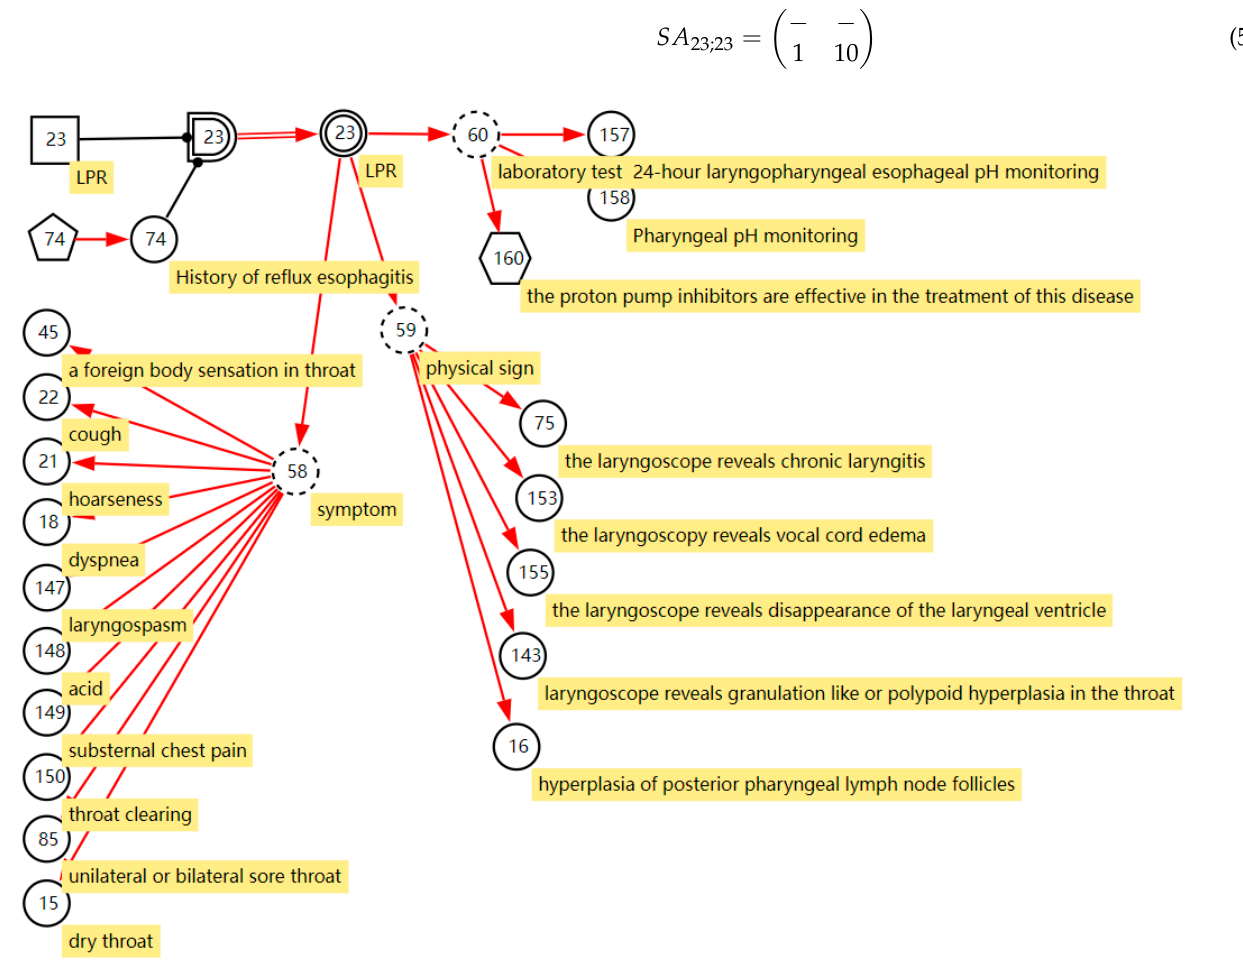
Figure 3. The DUCG of laryngopharyngeal reflux. 23 ) stands for the incidence of the disease when X 74,1 is true, Pr{ BX 23,1 }= Pr{ SA 23,1;23,1 B 23,1 } = 10 × 0.03 = 0.3. In this way, we express the e ff ect of risk factors on disease incidence in DUCG. Manifestations caused by LPR are drowning as the children of the BX -type variable; most of them are represented by the X-type variable standing for the nonspeci fi c clinical manifestations, except the manifestation “proton pump inhibitors are e ff ective in the treatment of this disease”. The manifestation SX 160 ( , proton pump inhibitors are e ff ective in the treatment of this disease) is the clinical gold standard for LPR diagnosis; it is represented by the SX -type variable. When the manifestation appears, the disease can be directly diagnosed based on this evidence. Appendix B shows the parameters of causal strength between variables of the sub-DUCG of LPR shown in Figure 3. This sub-DUCG model describes the relationship between LPR and its clinical diagnostic information, including the involved symptoms, signs, laboratory tests, diagnostic gold standard, risk factors, and other information. This information is understandable to doctors.